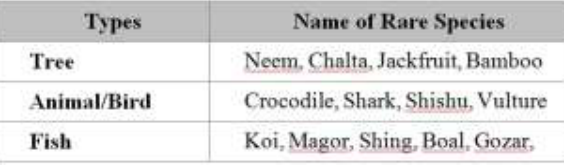
Table 5. List of Rare Species in Shyamnagar